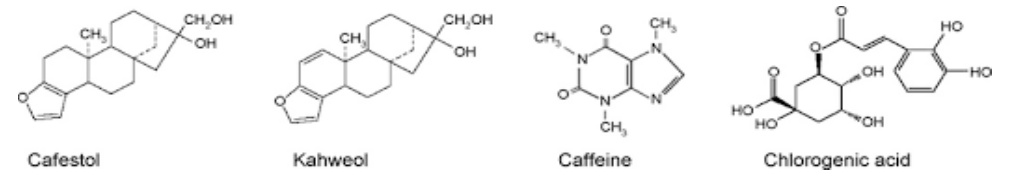
Figure 2. Chemical structures of proposed bioactive compounds in coffee (Adapted from reference Bonita et al., 2007) [86].